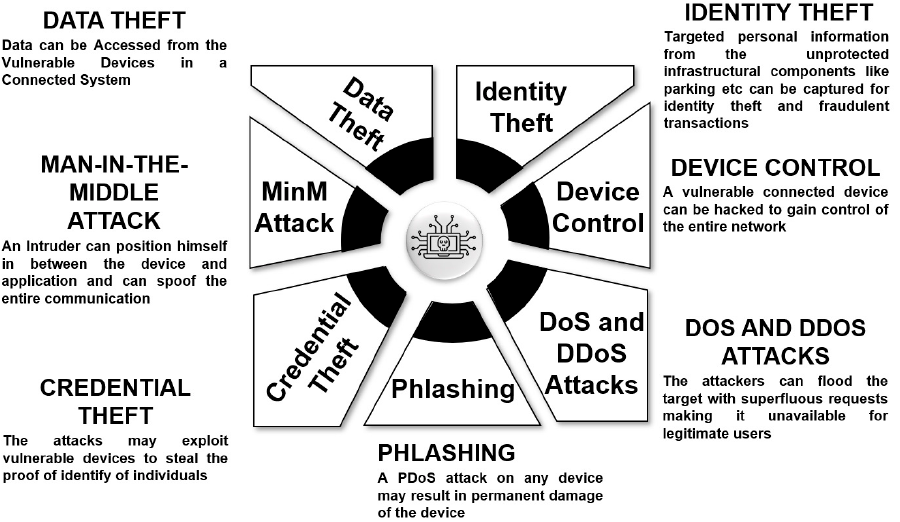
Figure 9. Types of attack on smart cities.